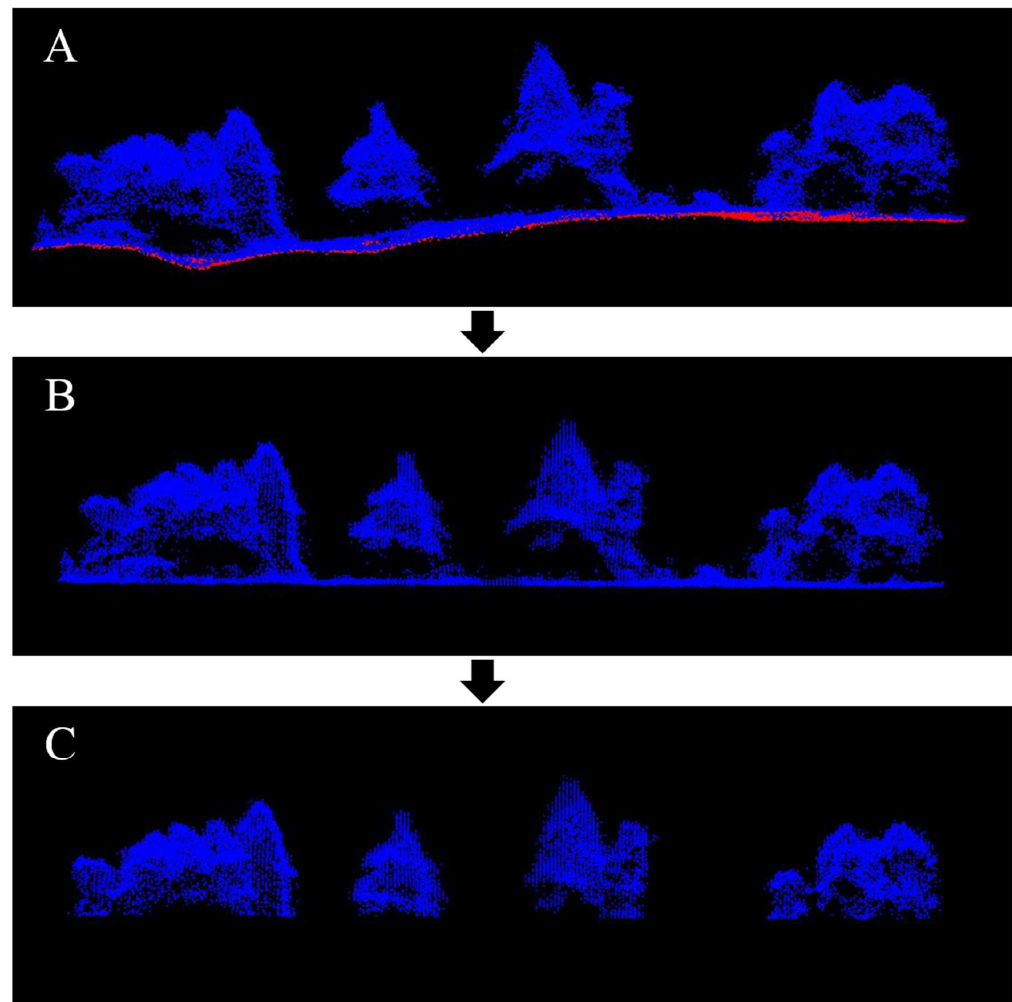
Figure 2. Point cloud pre-processing prior to tree segmentation: ( A ) Point cloud with initial ground classification are displayed in red, ( B ) Point cloud that has been normalized and filtered to remove ground points , which still included some non-tree points, and ( C ) The final point cloud after the second ground filtering and NDVI threshold only included tree points.